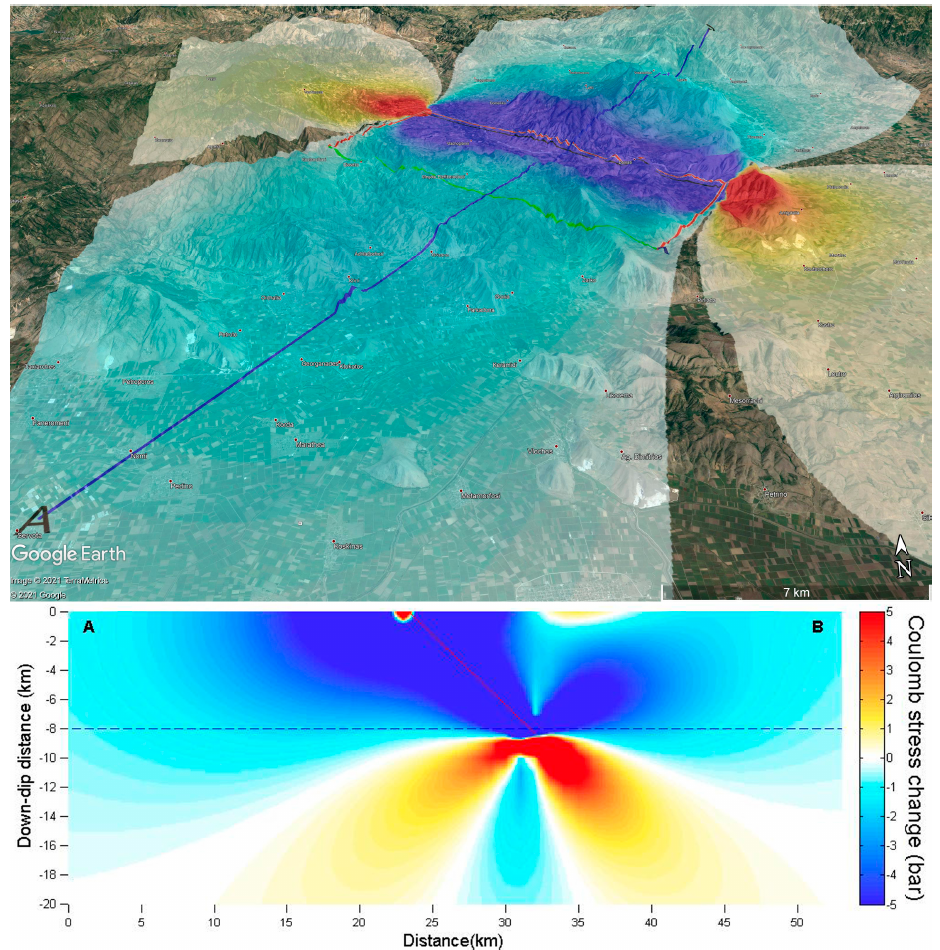
Figure 16. The seismic fault model (seismic source) of Figure 14 and the Coulomb static stress changes in horizontal ( top ) and vertical ( bottom ) sections that caused for receiver-faults similar to the first mainshock’s source-fault at the depth of 8 km. Modified from Chatzipetros et al.